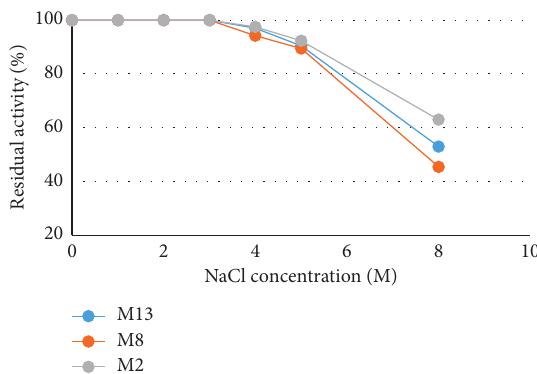
Figure 14: Effect of NaCl concentration on the stability of crude